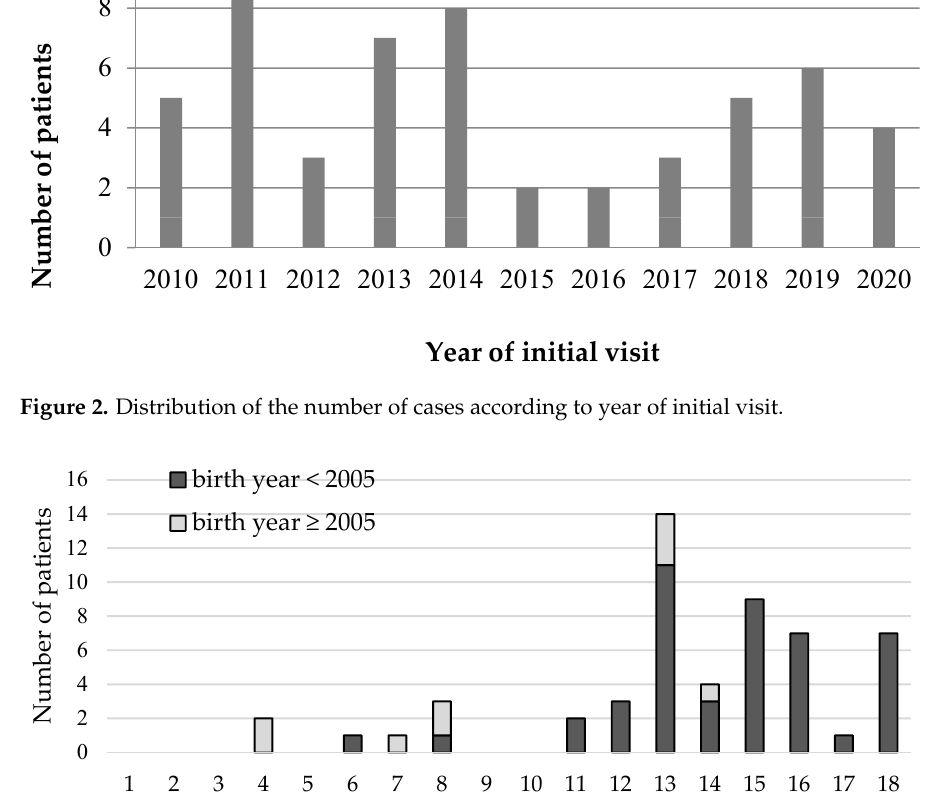
Figure 3. Distribution of age at onset of herpes zoster with complications.